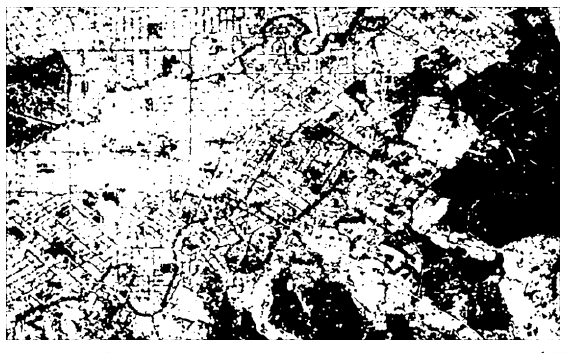
Figure 11. Zones not affected by the earthquake (black) vs. zones affected by the earthquake (white)